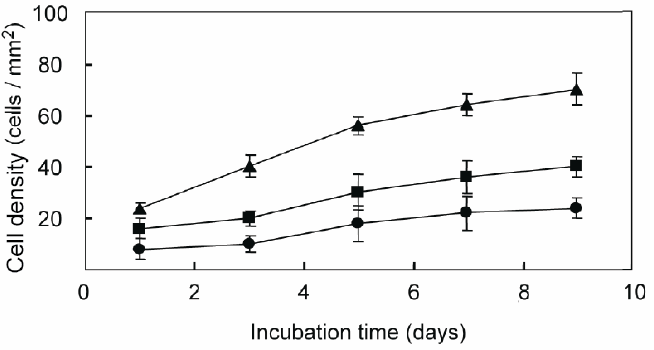
Figure 3. Time course of MSC growth on glass slides coated with: TiO2 ( ▲ ), collagen type I ( ■ ) and without any substance ( ●